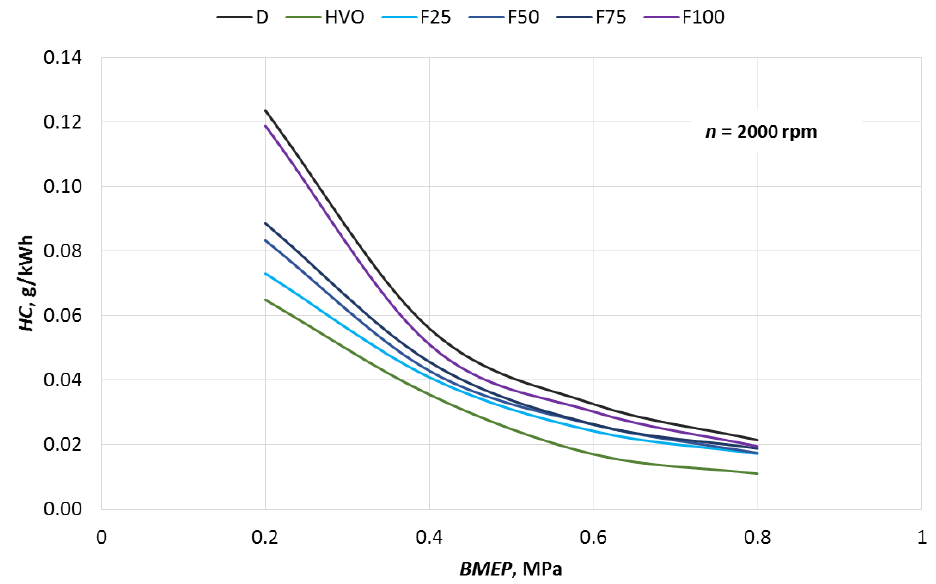
Figure 9. Dependence of hydrocarbon emissions on the load using different fuels.